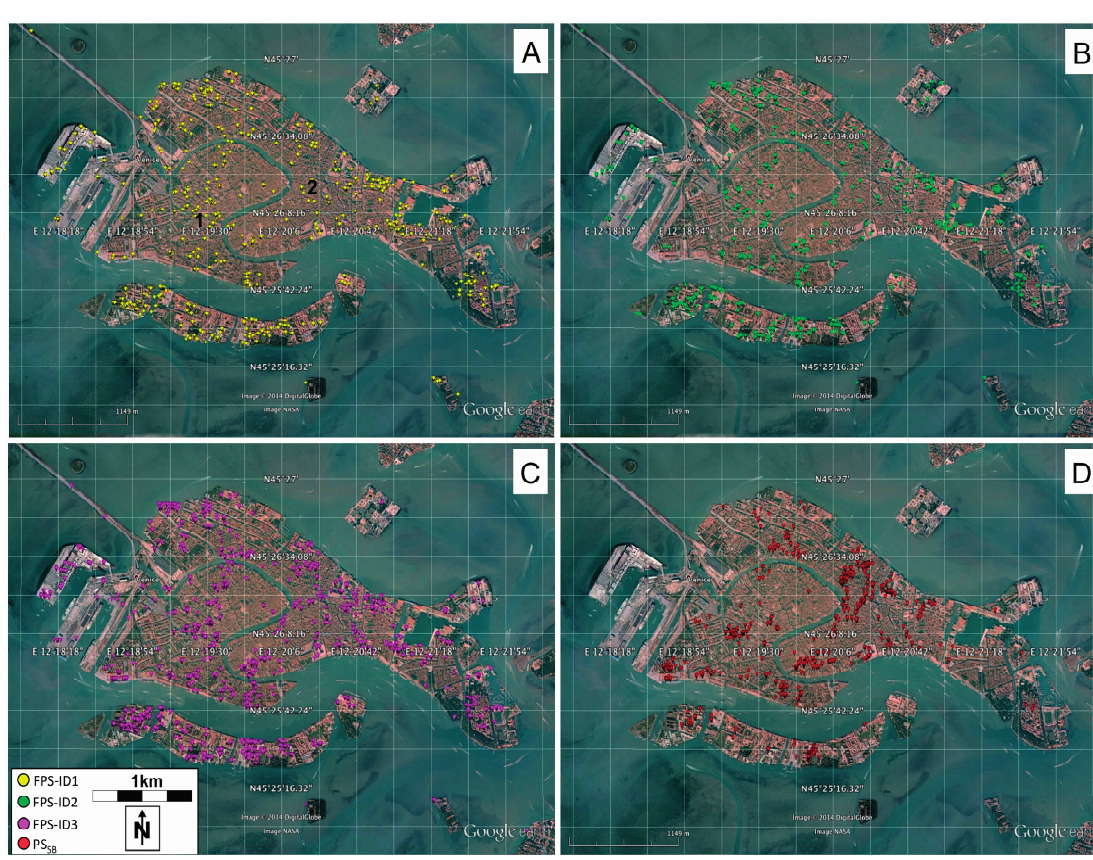
≤ 0.05 Figure 2. FPS and PS maps selected according respectively to Equation 2, 3 with σ SB (cid:2957) rad and γ ≤ 0.95. ( A ) Yellow, ( B ) green, and ( C )magenta refer to FPS respectively from InSAR pairs ID-1, ID-2 and ID-3, while ( D ) red dots to PS . Background optical image is SB from Google Earth engine and covers the area enclosed by the red frame in Figure 1. The number of FPS is 3091 for ID-1, 2692 for ID-2, and 4476 for